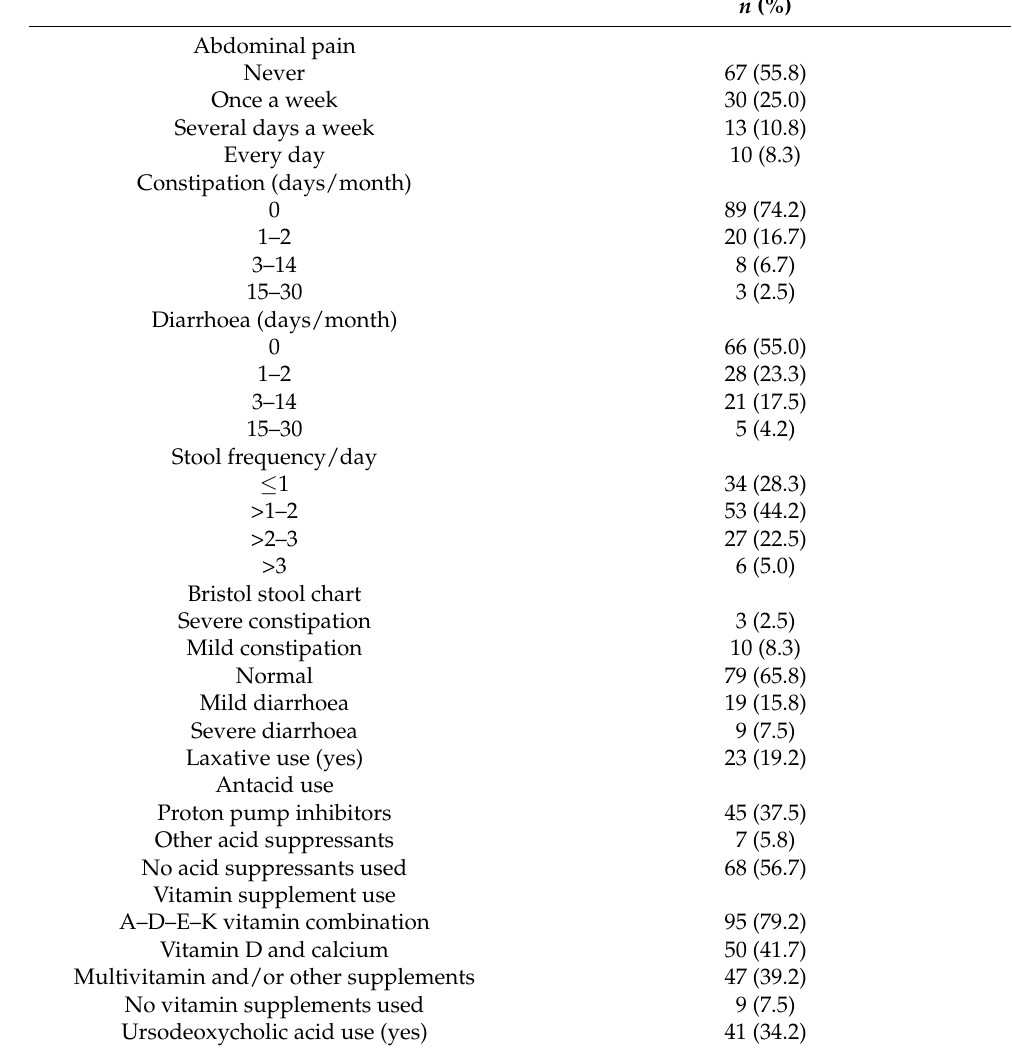
Table 3. Gastrointestinal symptoms and use of laxatives, acid suppressants, vitamin supplements and ursodeoxycholic acid in 120 adults with cystic